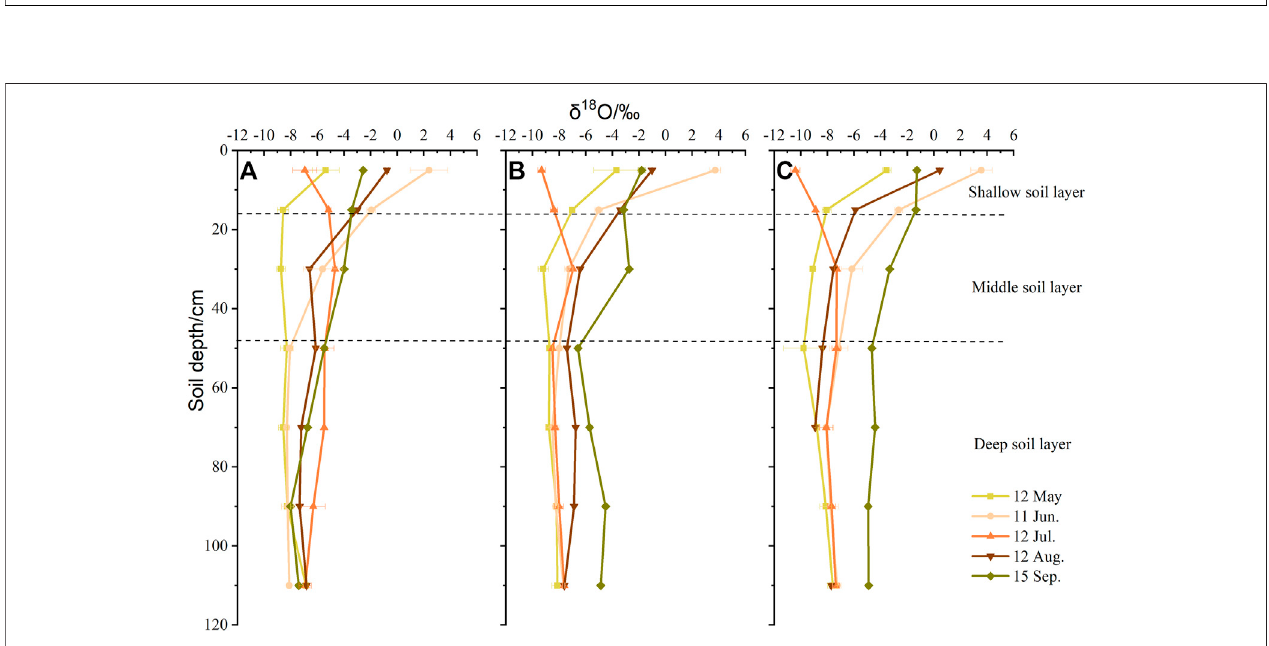
FIGURE 6 | Vertical variation in soil water δ 18 O values in positions with different dune geomorphology. (A) Windward, (B) top of the dune, and (C) leeward.